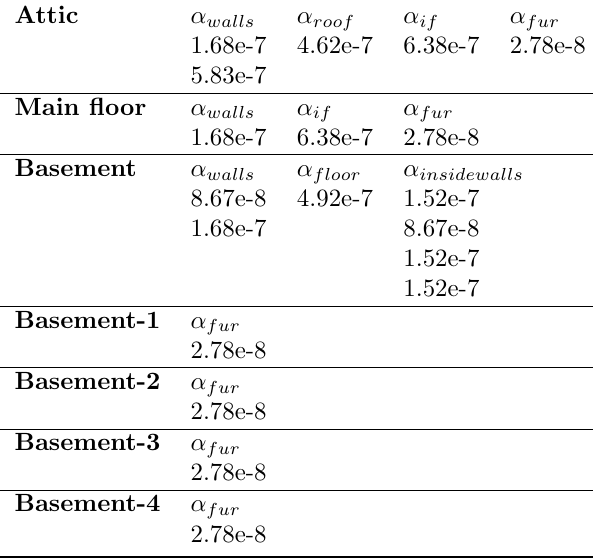
Table 5: Parameter specification in the multi-room model - Thermal diffiusivity [m 2 /K]